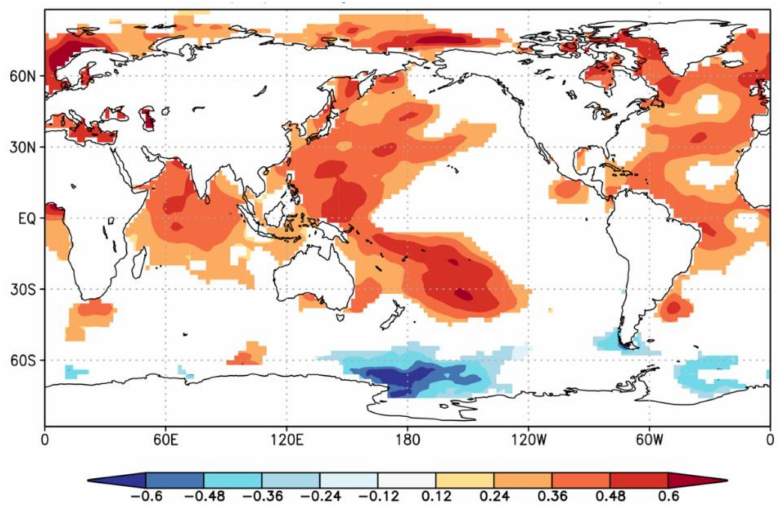
Figure 9. Spatial correlations of the reconstructed pMar-pOct mean temperature with global ERSST v5 SSTs during 1958–2016. Shading denotes the correlations that are statistically significant at the 0.10